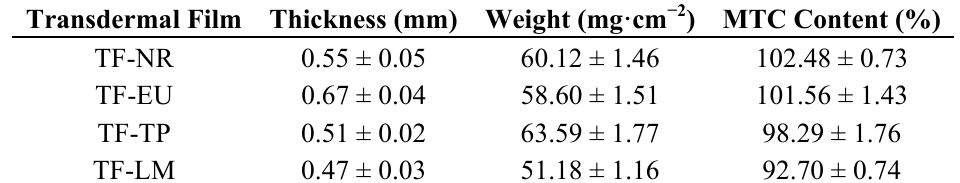
Table 3. Thickness, weight and drug content uniformity of the MTC transdermal films (mean ± SD, n =